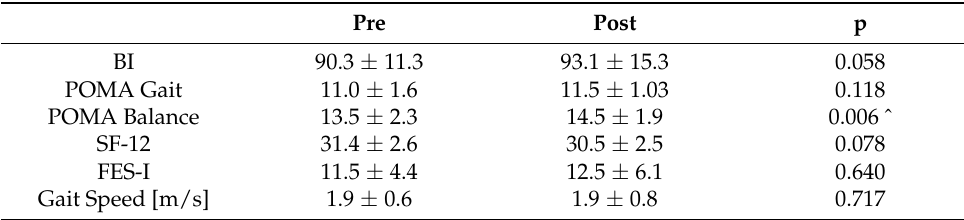
Table 3. Mean pre- and post-intervention scores and standard error of the mean on the BI, POMA gait and Balance, SF-12,